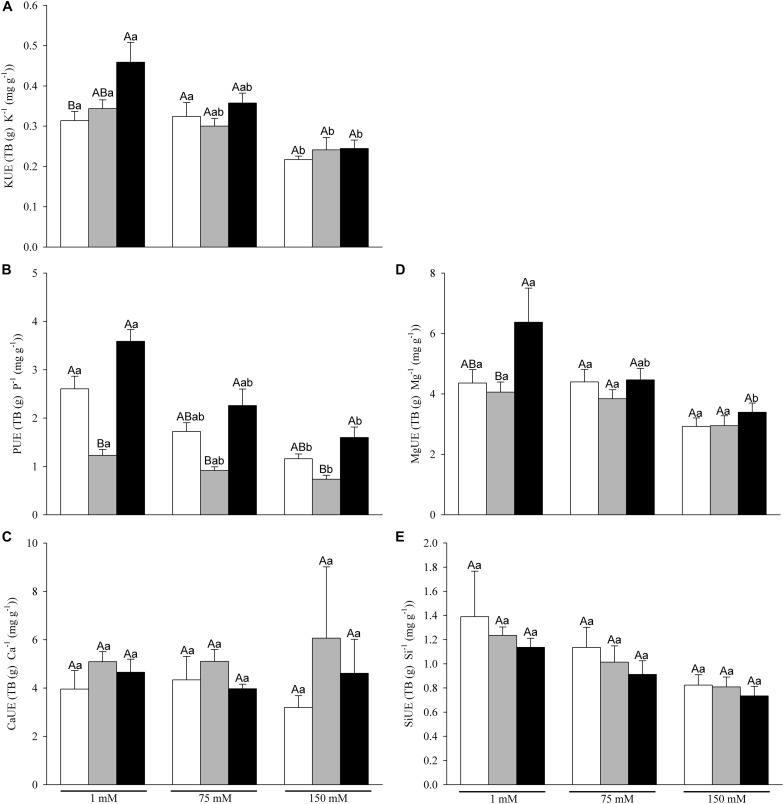
Nutrient Use Efficiency [Total Biomass, TB (g)/nutrient concentration (mg g–1)]. (A) K+, KUE; (B) P, PUE; (C) Mg2+, MgUE; (D) Ca2+, CaUE and (E) Si, SiUE. Values are mean and SE of six replicates of of C, P and AM plants (white, gray and black bars, respectively) at the three salinity levels (1, 75 and 150 mM NaCl). Different capital letters indicate significant differences among nutritional levels (C, P and AM) within the same salt level, and lowercase letters indicate significant differences among salt levels within the same nutritional level, from post hoc Tukey test.